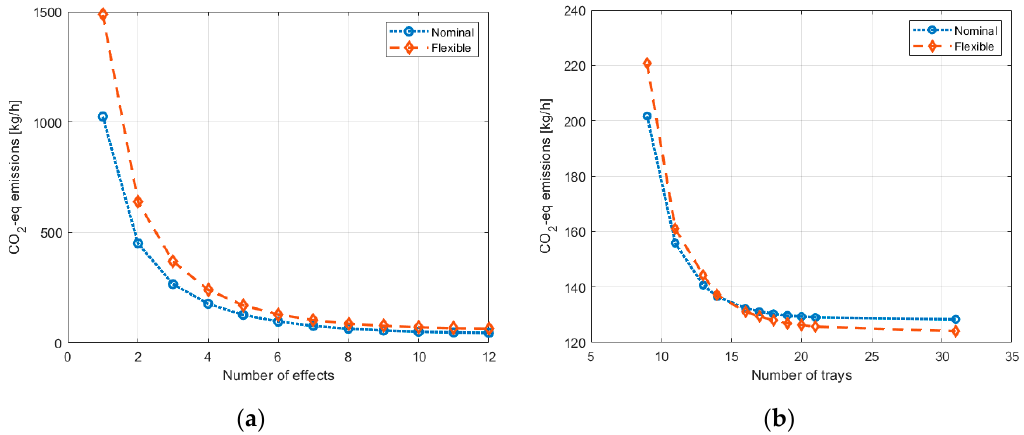
Figure 9. CO 2 average emissions: ( a ) multiple-effect evaporator; ( b ) distillation